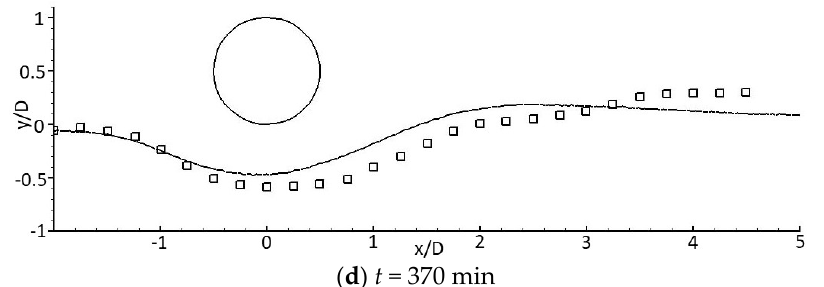
Figure 4. Comparisons of the computational and experimental scour profiles.